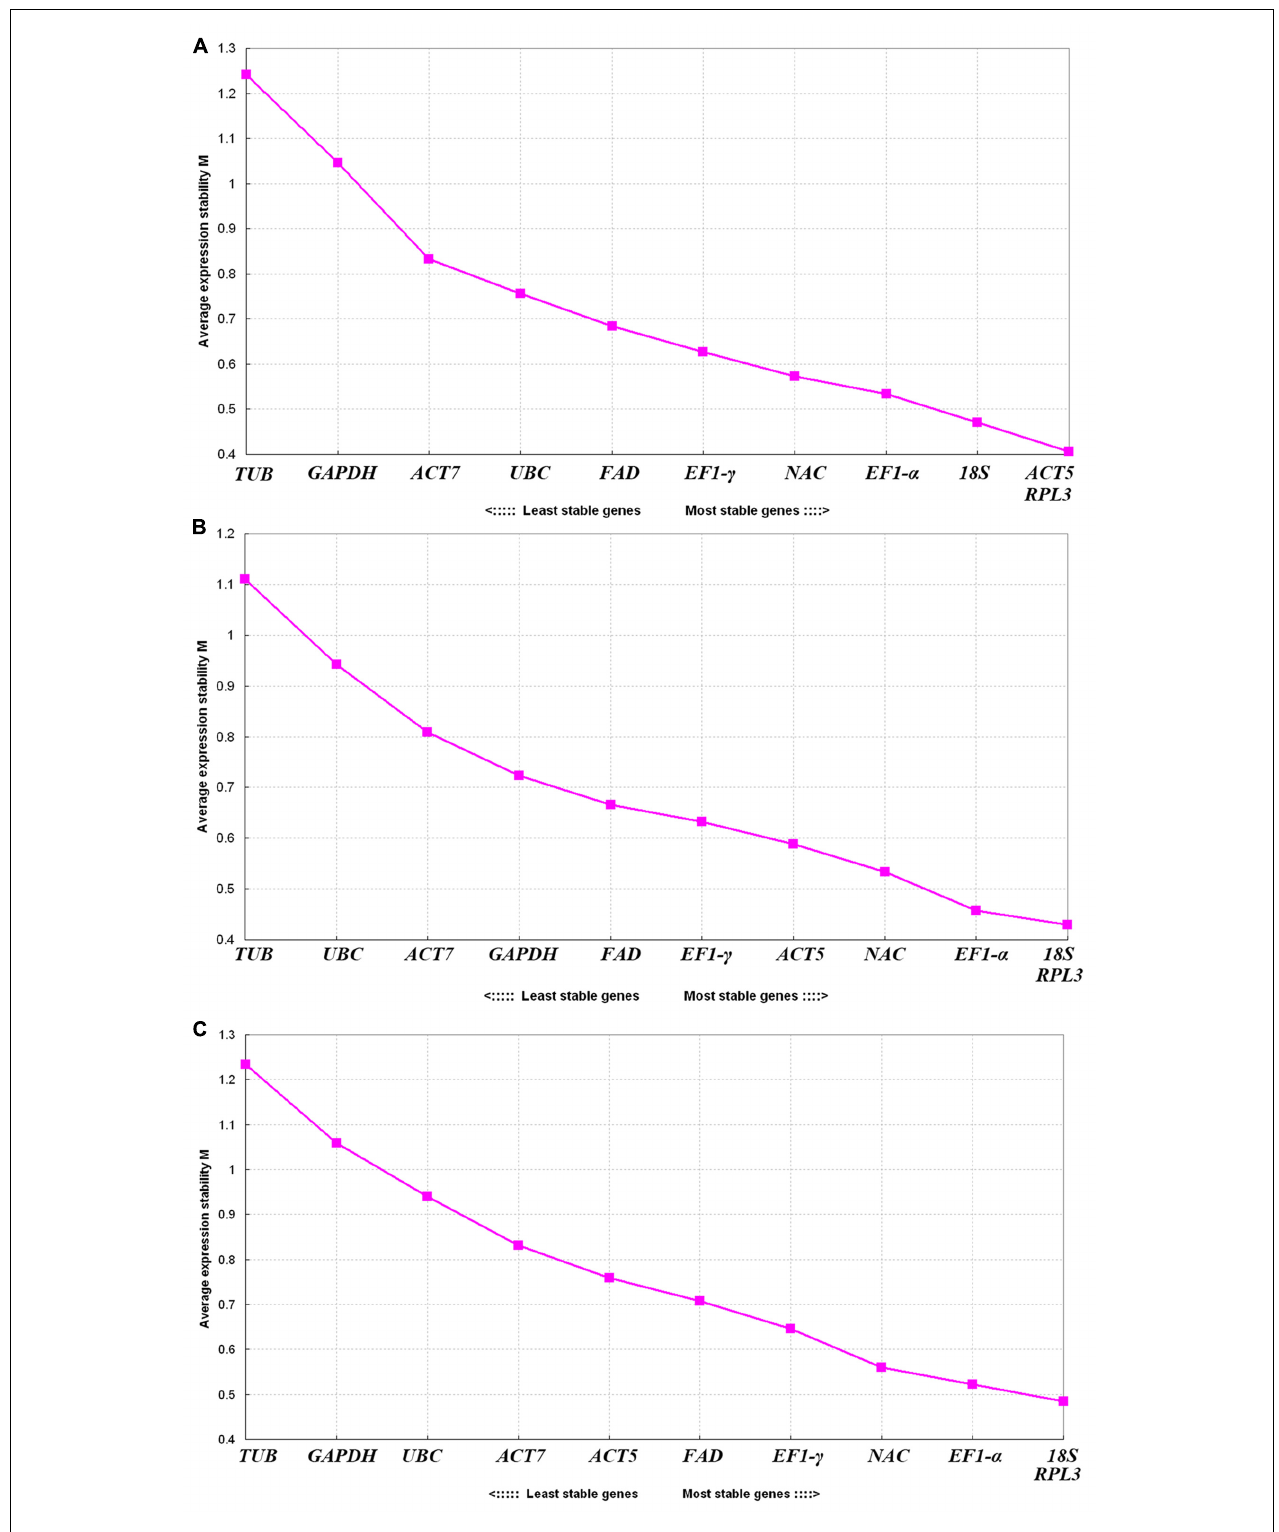
FIGURE 3 | Expression stability values ( M ) of eleven reference genes calculated through GeNorm. (A) Different tissues, (B) flower samples of different developmental stages, and (C) all samples. Lower average expression stability levels ( M value) denote more stable expression.